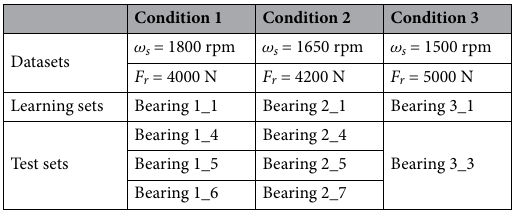
Table 3. Dataset description for PRONOSTIA test bench.